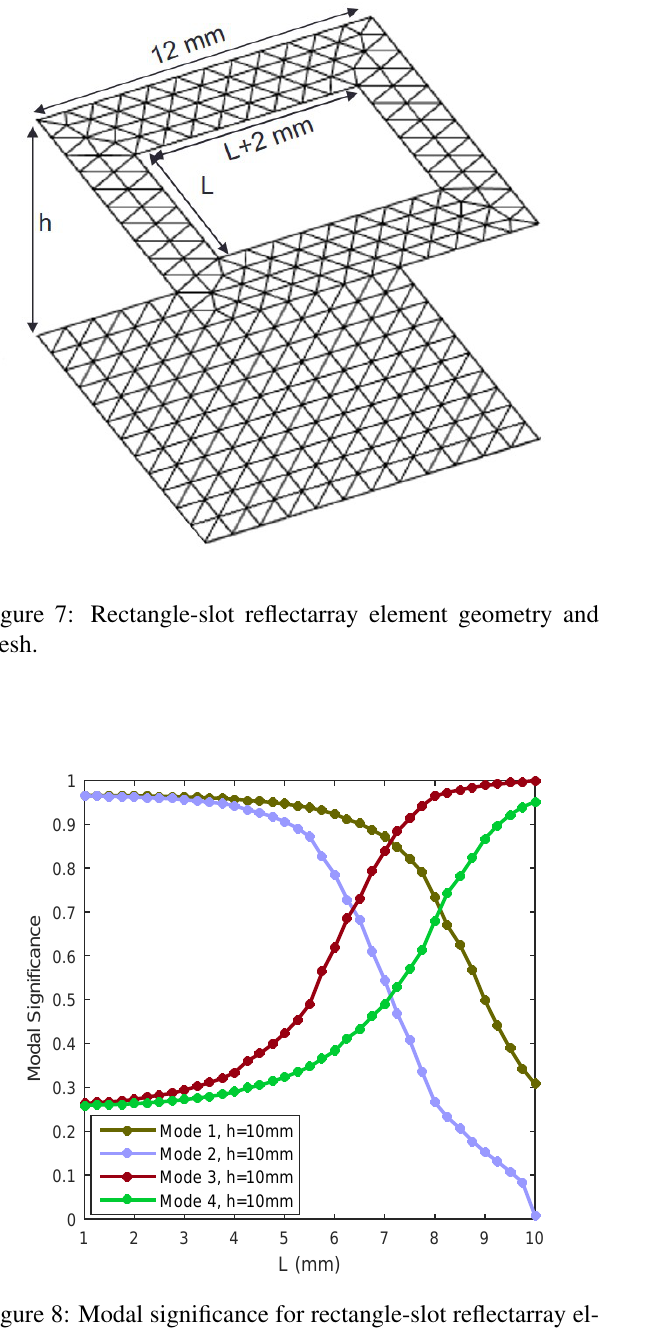
Figure 8: Modal significance for rectangle-slot reflectarray el- ement.